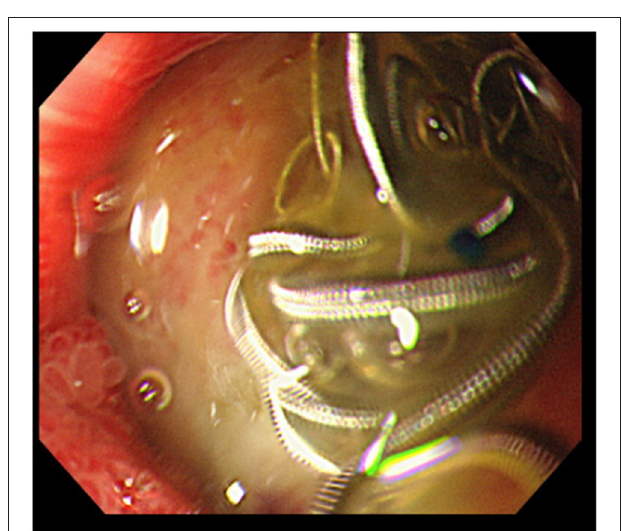
FIGURE 2 | Upper gastrointestinal endoscopy imaging findings. Visible are the ulcer and leakage of the coils used to perform embolization in the anterior wall of the duodenal